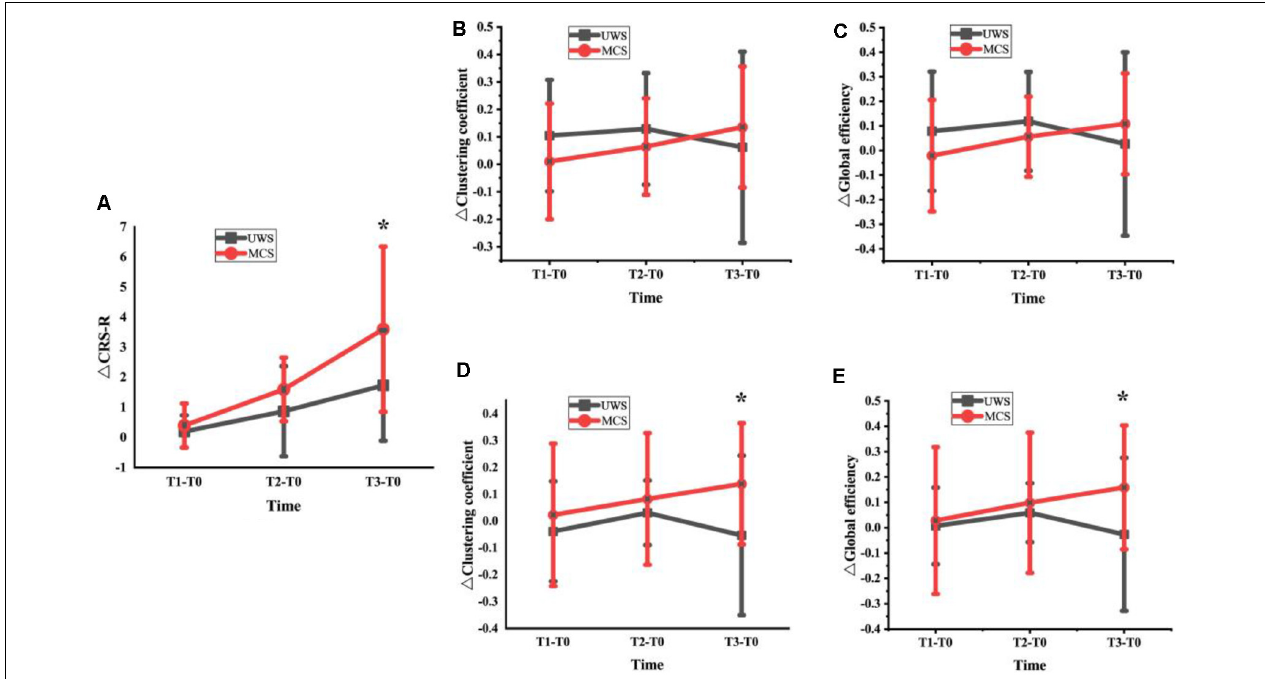
FIGURE 4 | Changes of CRS-R scores (A) , average clustering coefficient and global network efficiency at T1, T2 and T3 for UWS and MCS groups [Beta band: (B) and (C) ; Gamma band: (D) and (E) ; *denotes a significant difference (*denotes p < 0.05, FDR corrected)].